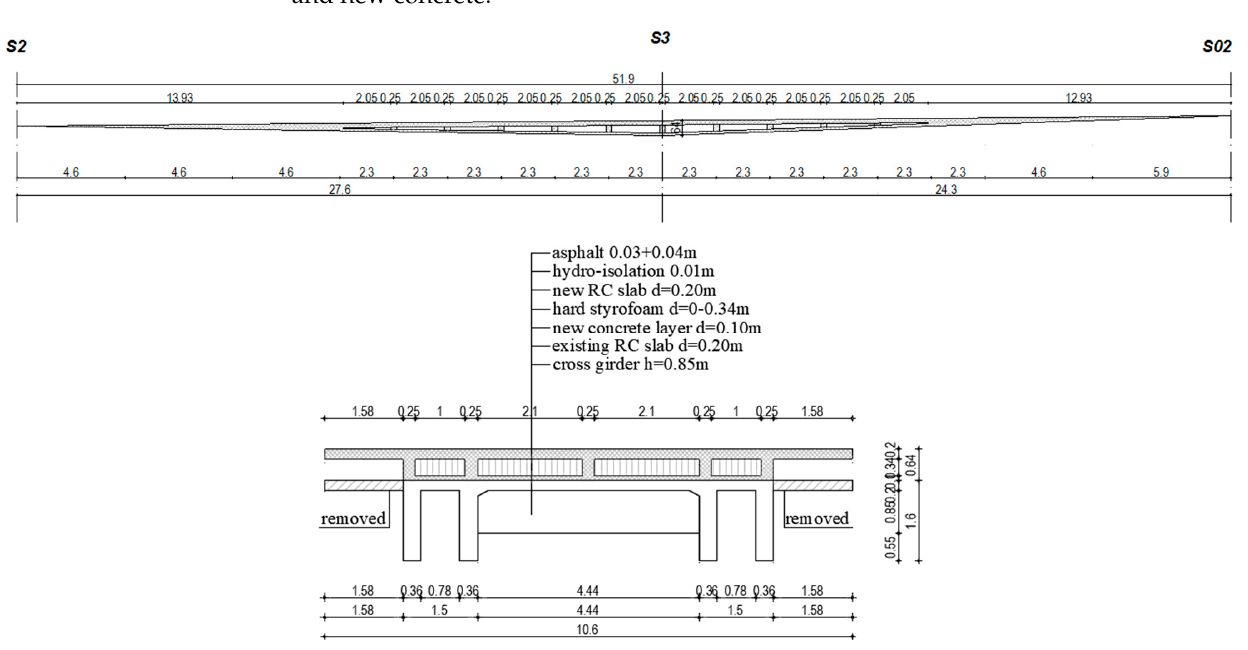
Figure 12. The geometry of the RC grill structure.